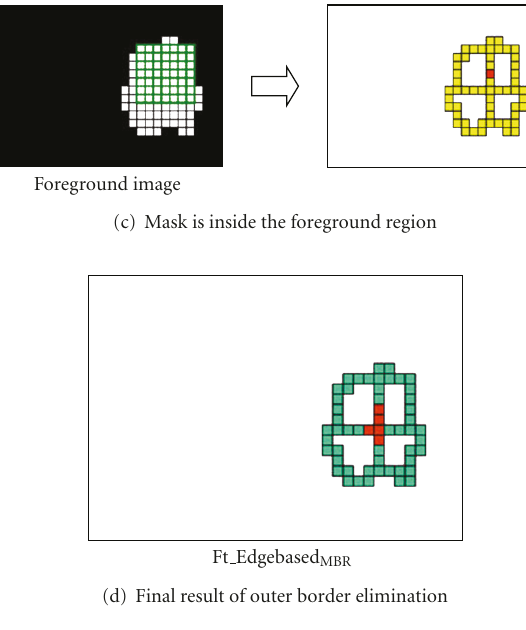
Figure 12: Illustrations of boundary elimination.